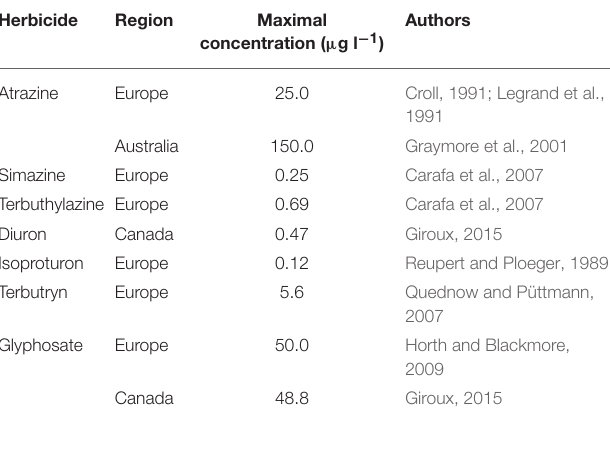
TABLE 1 | Examples of maximal concentrations of herbicides (PSII-inhibitors and glyphosate) in waters of different regions.